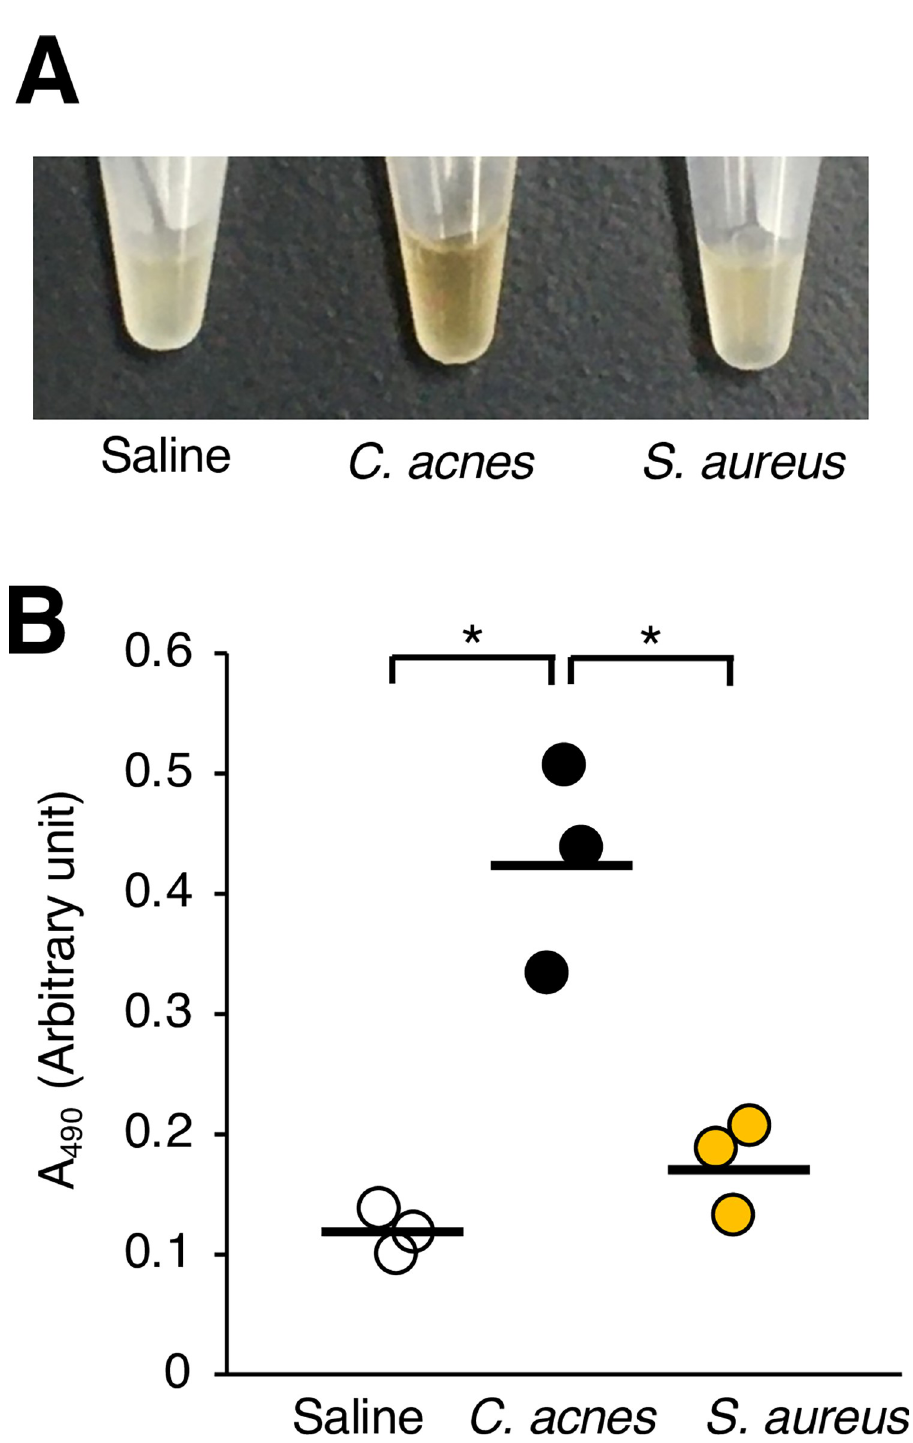
Fig 2. Comparison of melanization induction by C . acnes and S . aureus in silkworm hemolymph. Silkworms were injected with saline (Saline), C . acnes cell suspension ( C . acnes ; 1 x 10 8 cells/larva), or S . aureus cell suspension ( S . aureus ; 1 x 10 8 cells/larva). After incubation for 3 h at 37˚C, the silkworm hemolymph was collected. Photographs of the silkworm hemolymph were taken ( A ), and absorbance at 490 nm (A 490 ) ( B ) was measured. The arbitrary unit was defined as the absorbance at 490 nm of a sample of silkworm hemolymph (50 μ l) mixed with saline (50 μ l). n = 3/ group. Statistically significant differences between groups were evaluated using the Tukey test. � P < 0.05.